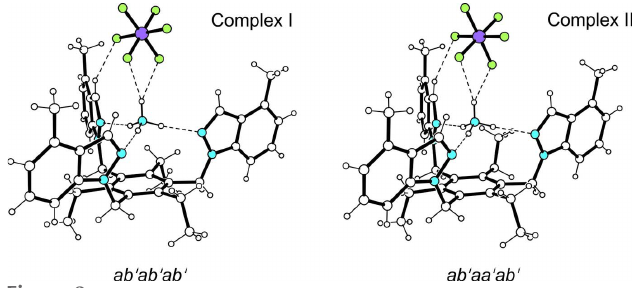
Figure 2 Ball-and-stick representation (side view) of the complexes in the crystal structure of the title complex.